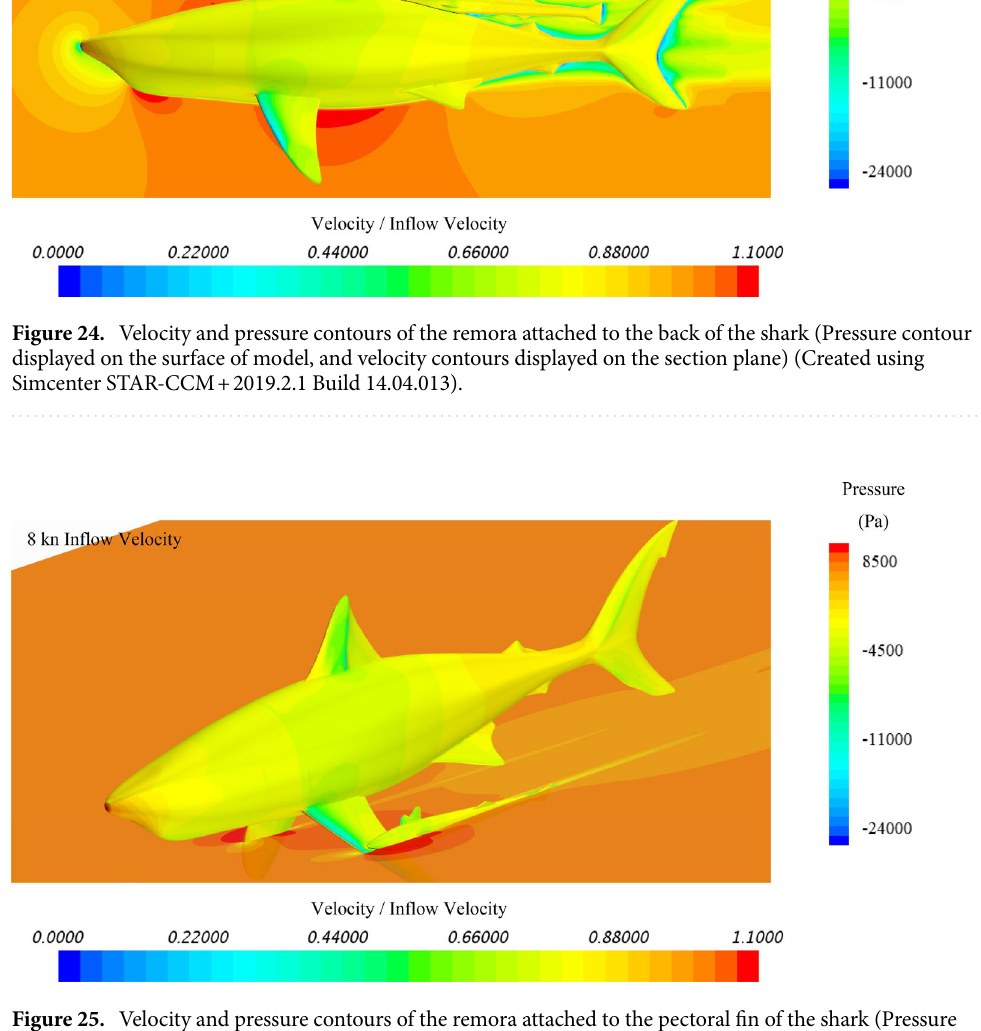
Figure 25. Velocity and pressure contours of the remora attached to the pectoral fin of the shark (Pressure contour displayed on the surface of model, and velocity contours displayed on the section plane) (Created using Simcenter STAR-CCM + 2019.2.1 Build